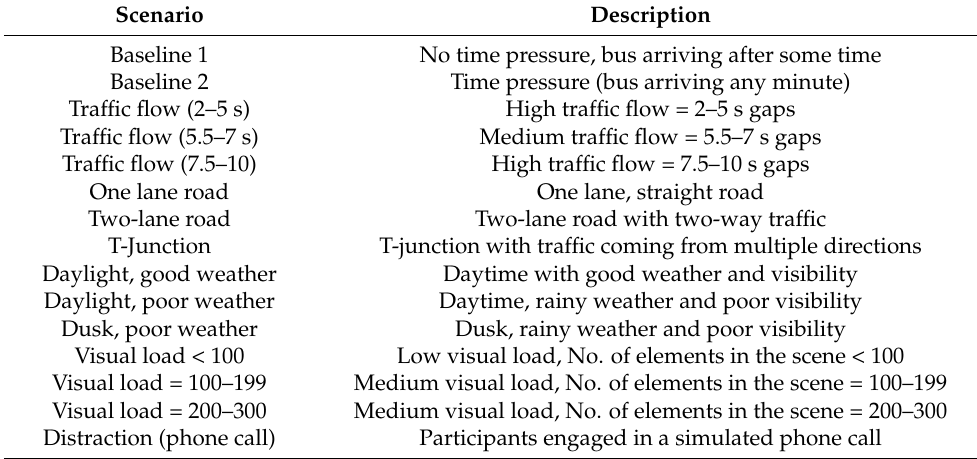
Table 1. Summary of study crossing scenarios.